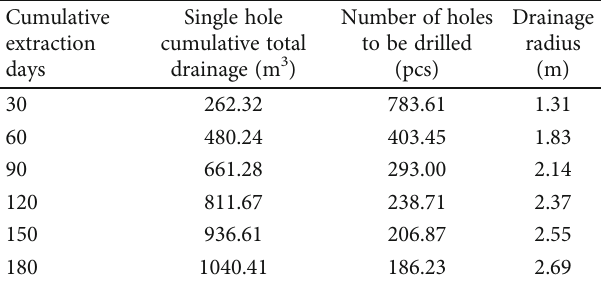
Table 4: Comparison of the calculation results of the extraction radius of the borehole ( fi tting the negative exponential curve of extraction attenuation).